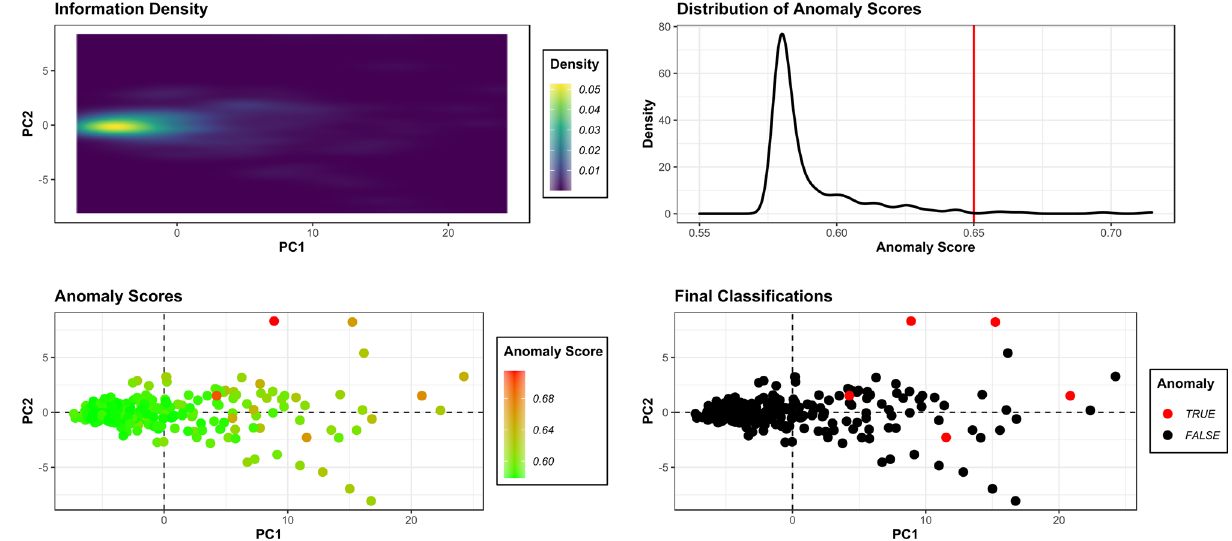
Figure 2. Anomaly detection results using Isolation Forests. Top Left Panel: Density of information within Principal Components Analysis. Top Right Panel: Distribution of Anomaly Scores; Vertical red line marks the acceptable threshold. Bottom Left Panel: Scatter plot heat map indicating the anomaly scores for each point. Bottom Right Panel: Final classifications of points as anomalies (True) or not (False). Figure created using the ggplot2 R